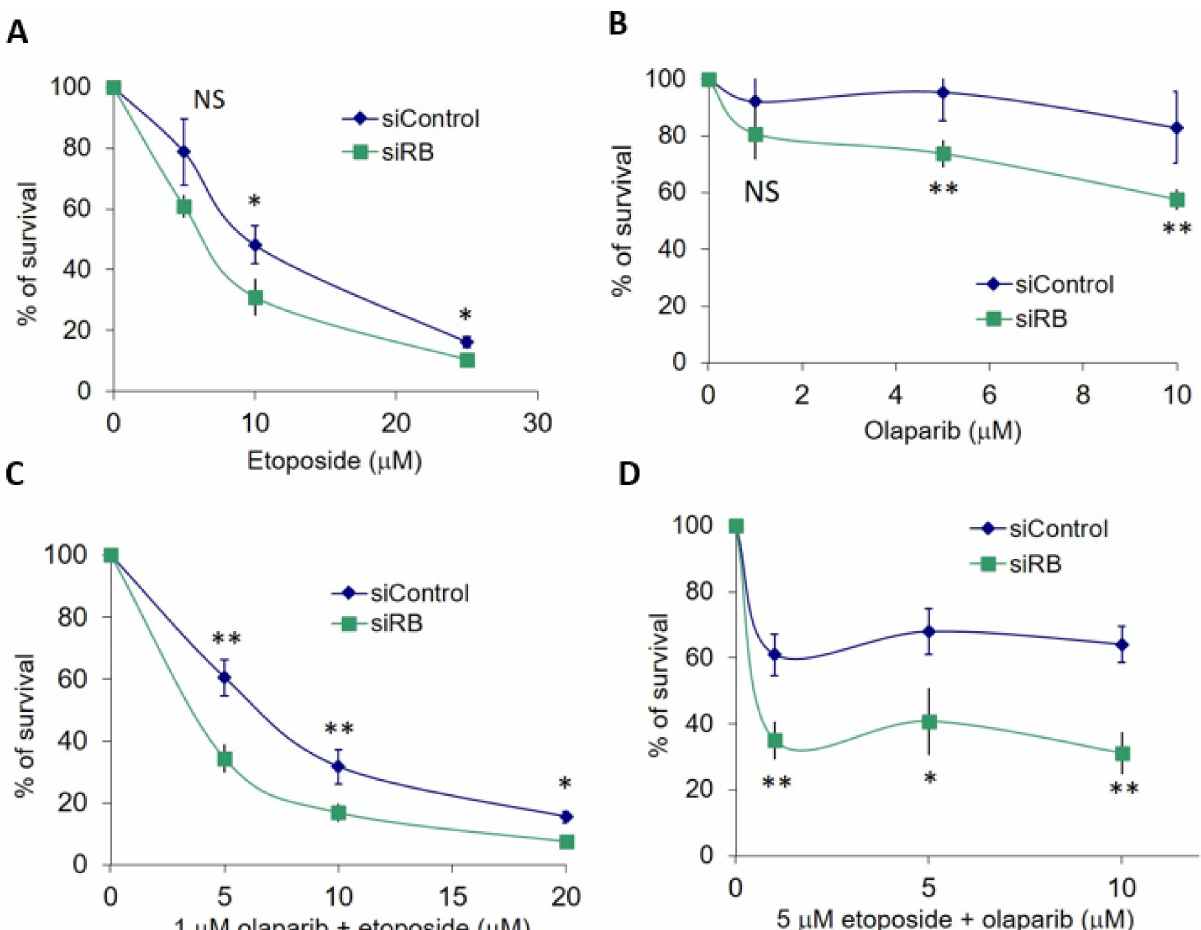
Figure 3. ( A ) MTT assay in RB knocked-down (siRB) and control siRNA (siControl)-treated U2OS cells showed cell survival after treating various dosages of etoposide for three days. ( B ) MTT assay in RB knocked-down and control siRNA-treated U2OS cells showed cell survival after treatment with various dosages of olaparib for three days. ( C ) MTT assay in RB knocked-down and control siRNA-treated U2OS cells showed cell survival after co-treatment with 1 µ M olaparib with various dosages of etoposide for three days. ( D ) MTT assay in RB knocked-down and control siRNA-treated U2OS cells showed cell survival after co-treatment with 5 µ M etoposide with various dosages of olaparib for three days. Experiments were repeated three times. Data are shown as mean ± standard deviation and analyzed using two-tailed unpaired t -test: * represents p < 0.05, ** represents p < 0.01, NS represents no